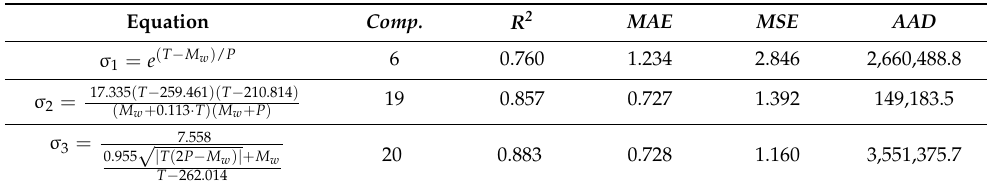
Table 2. The three SR-extracted equations for electrical conductivity and their respective accuracy metrics. Comp . is the equation complexity. Equation Comp. R 2 MAE